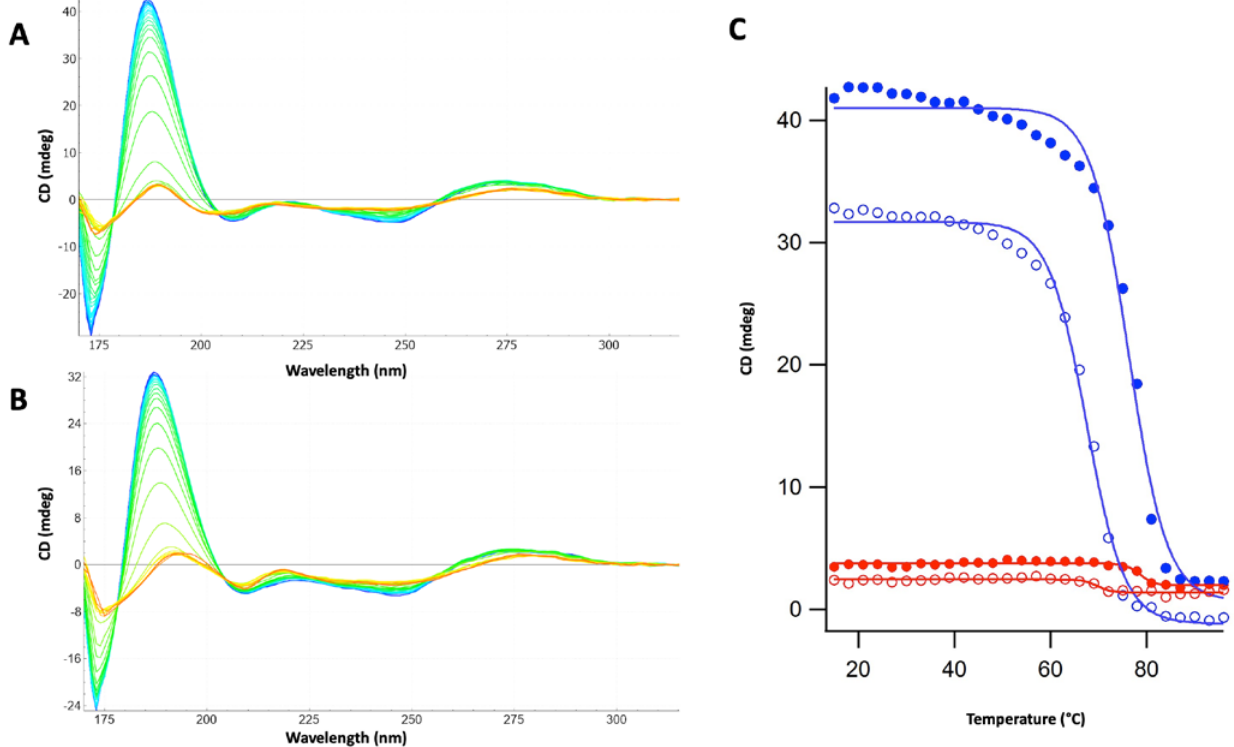
Figure 4. ColE1 origin temperature melting using SRCD (from blue 15 °C to red 95 °C). ( A ) Melting in the presence of the CTR. ( B ) Melting without the CTR. At 15 °C, ColE1 origin forms a B helix. This can be concluded from the comparison of the whole spectra with the literature [44,45] and our in-house database. The correlation between spectra in 4 and that of B-form helix was investigated using Pearson correlation tests. We found a correlation of 0.94611 for a p -value of 9.09136 × 10 −76 for colE1 dsDNA at 15 °C and a correlation of 0.9604 for a p -value of 3.8568 × 10 −85 for colE1 dsDNA in the presence of the CTR. ( C ) The corresponding T m were 76.0 ± 0.5 °C, 67.5 ± 0.3 °C, 78.6 ± 0.6 °C and 69.7 ± 0.8 °C at 187 (blue) and 274 (red) nm with (full circle) and without the CTR (empty circle), respectively. Note that SRCD values in Figures 3 and 4A cannot be compared due to molecular alignment and the influence of SRLD signal that depends on cell orientation (see Section